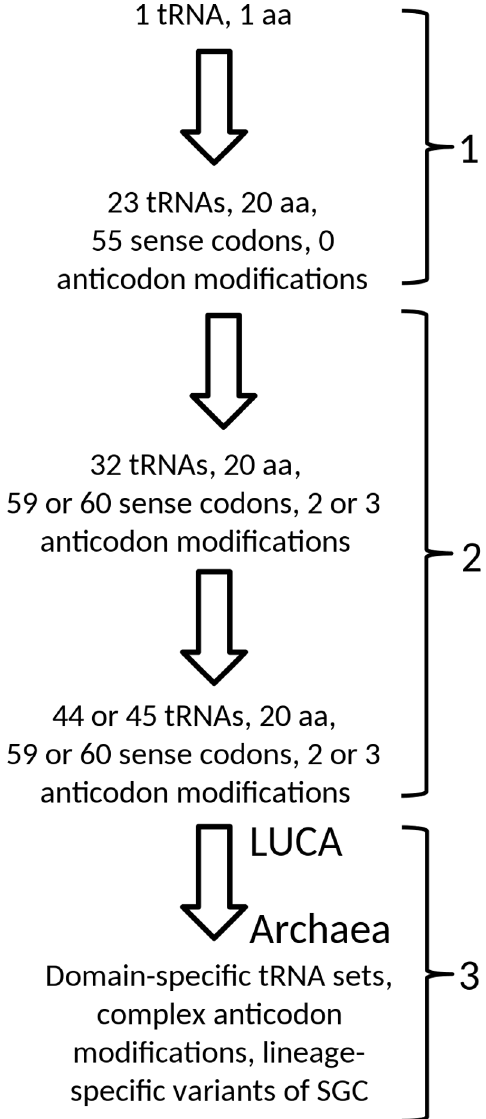
Fig 7. Summary of the proposed three stages in the evolutionary development of the tRNA set in the standard genetic code.